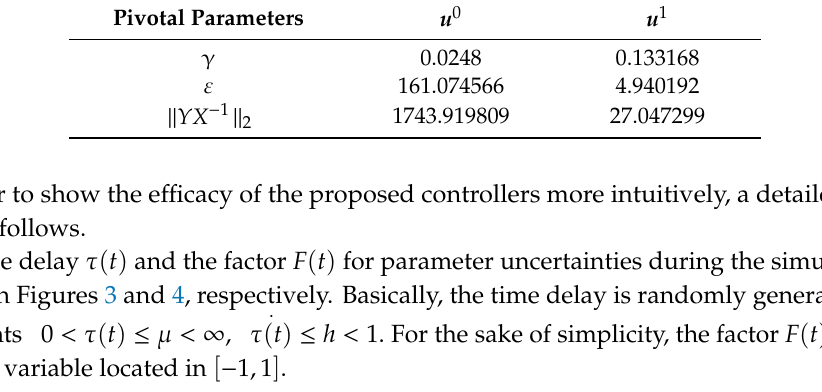
Table 2. Comparison of solutions for proposed controllers.